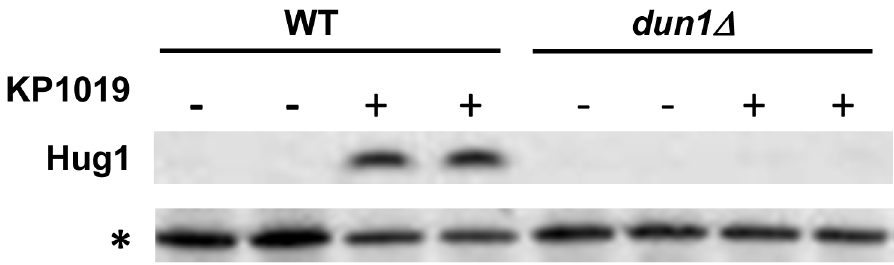
Fig 2. KP1019 induced DUN1 -dependent expression of Hug1 protein and phosphorylation of Rad53. A. Early log phase wild-type (WT) and dun1 deletion ( dun1 Δ ) strains were treated with 80ug/ml KP1019 for three hours (+) or untreated (-) and assayed for Hug1 protein expression. Western blot analysis was carried out as described in Materials and Methods. Each sample was run in duplicate lanes and “ * ” indicates a non- specific band that serves as the loading control. B. WT cells were incubated with increasing concentrations of KP1019 for one hour and assayed for Rad53 protein phosphorylation. Western blots were carried out as described in Materials and Methods. The shift in position of Rad53 protein consistent with increased phosphorylation is indicated by Rad53-TAP-P, while unmodified Rad53 is indicated by